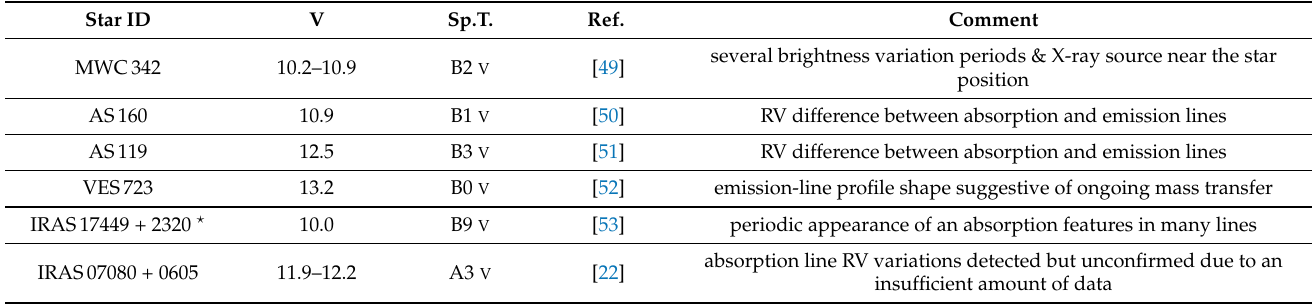
Table 3. Candidate FSCMa-type binary